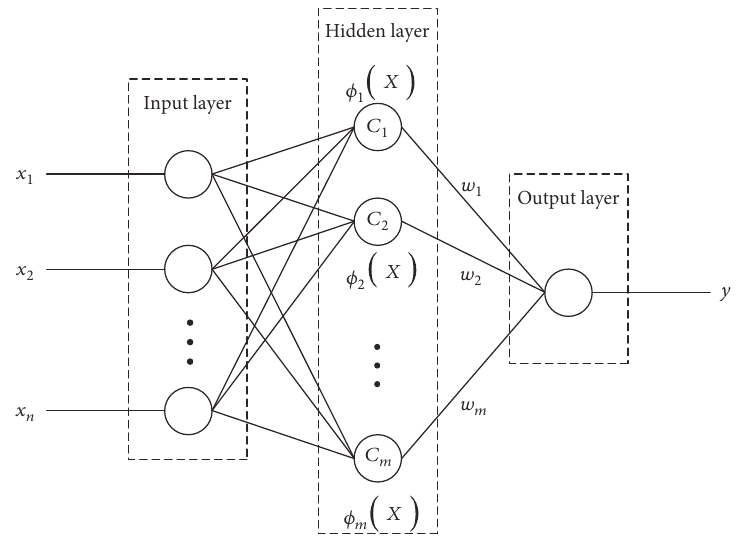
Figure 2: Topology structure of the RBF neural